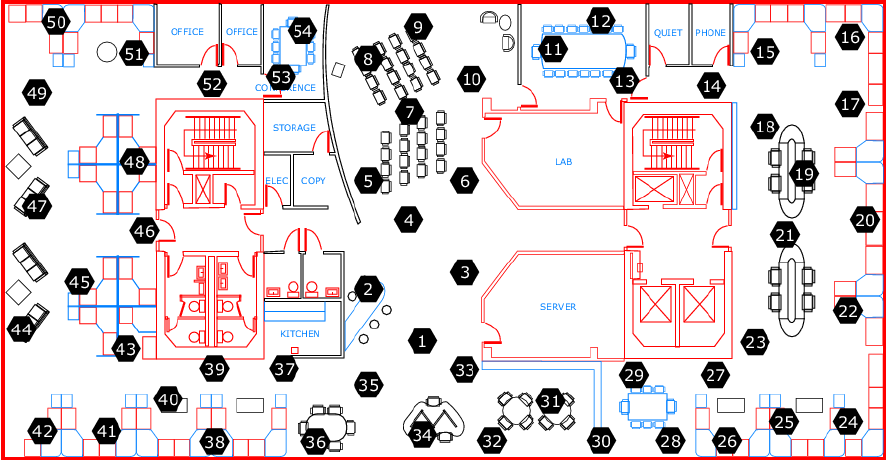
Figure 7. Distribution of 54 sensors in Intel Berkeley Research lab